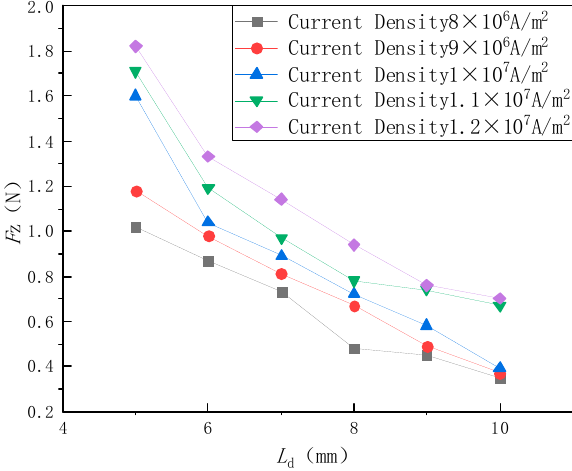
Figure 6. The relationship between the force of the vertical electromagnet to the rotor along z axis and the distance between them in different electric current densities.